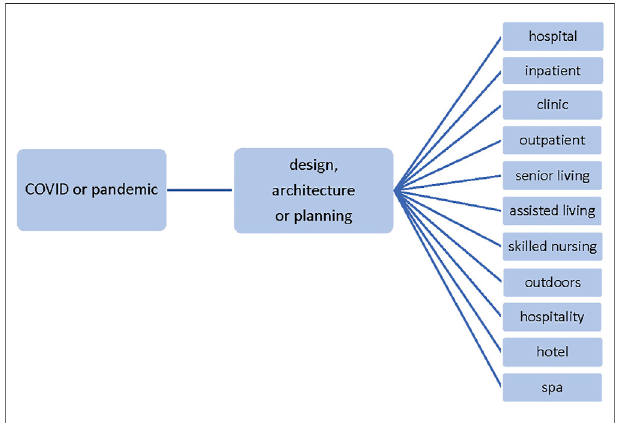
FIGURE 1 | Search term strategy.